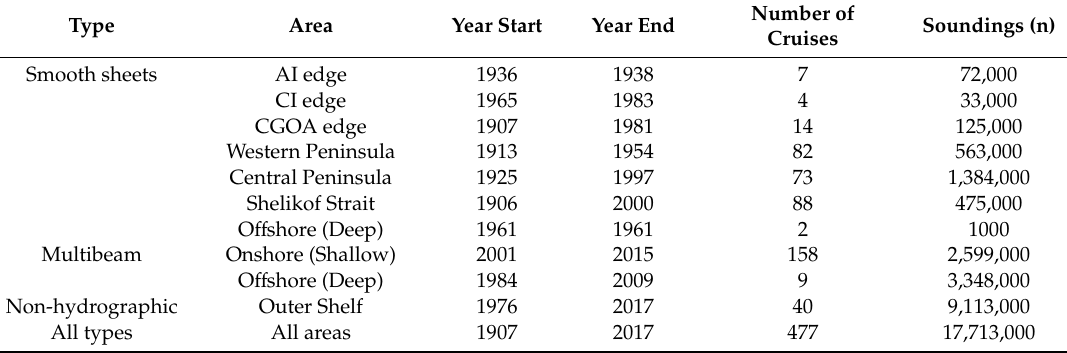
Table 1. Summary of data sources used for this compilation. For continuity, we included small overlapping data sets from previously published compilations of the Aleutian Islands (AI edge), Cook Inlet (CI edge), and central Gulf of Alaska (CGOA edge). Large groups of overlapping smooth sheets covered much of the inshore area of the Western Peninsula, Central Peninsula, and Shelikof Strait, and there were just two o ff shore, deeper smooth sheets. Shallow multibeam data overlapped some of the shallow areas with smooth sheets, while deeper multibeam mostly covered the Aleutian Trench. Non-hydrographic quality single-beam data, mostly from fishery research cruises, filled a large gap in the outer